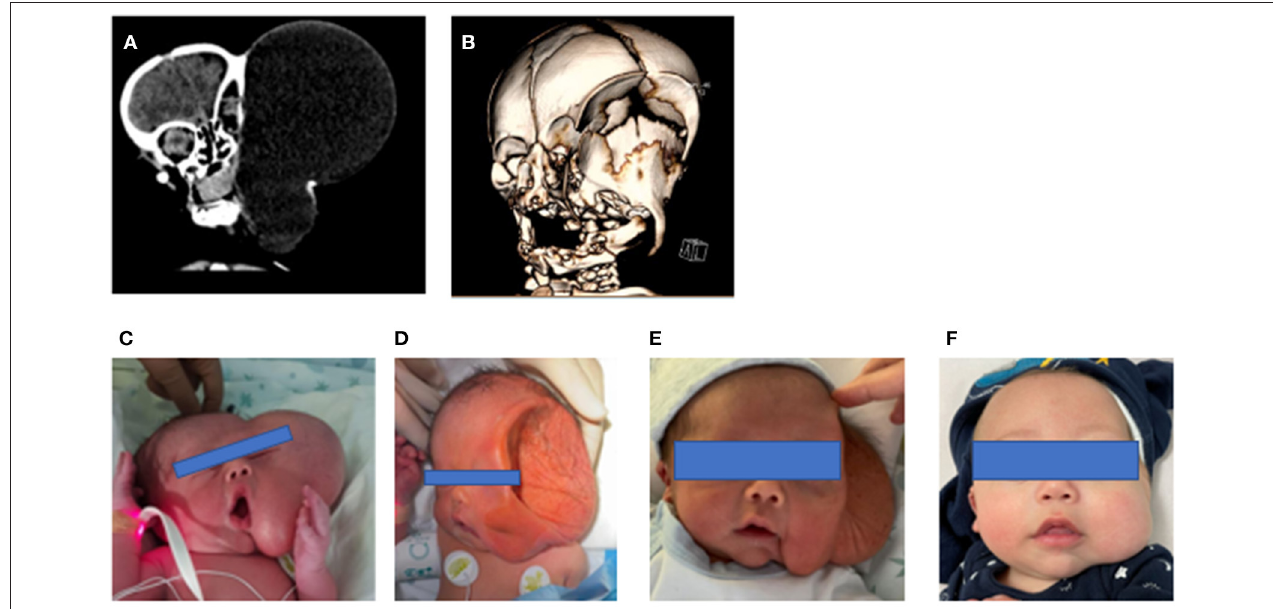
FIGURE 5 | (A) Postnatal TC scan, (B) 3D CT reconstruction, (C) pre-sclerotherapy appearance, (D–F) post-sclerotherapy